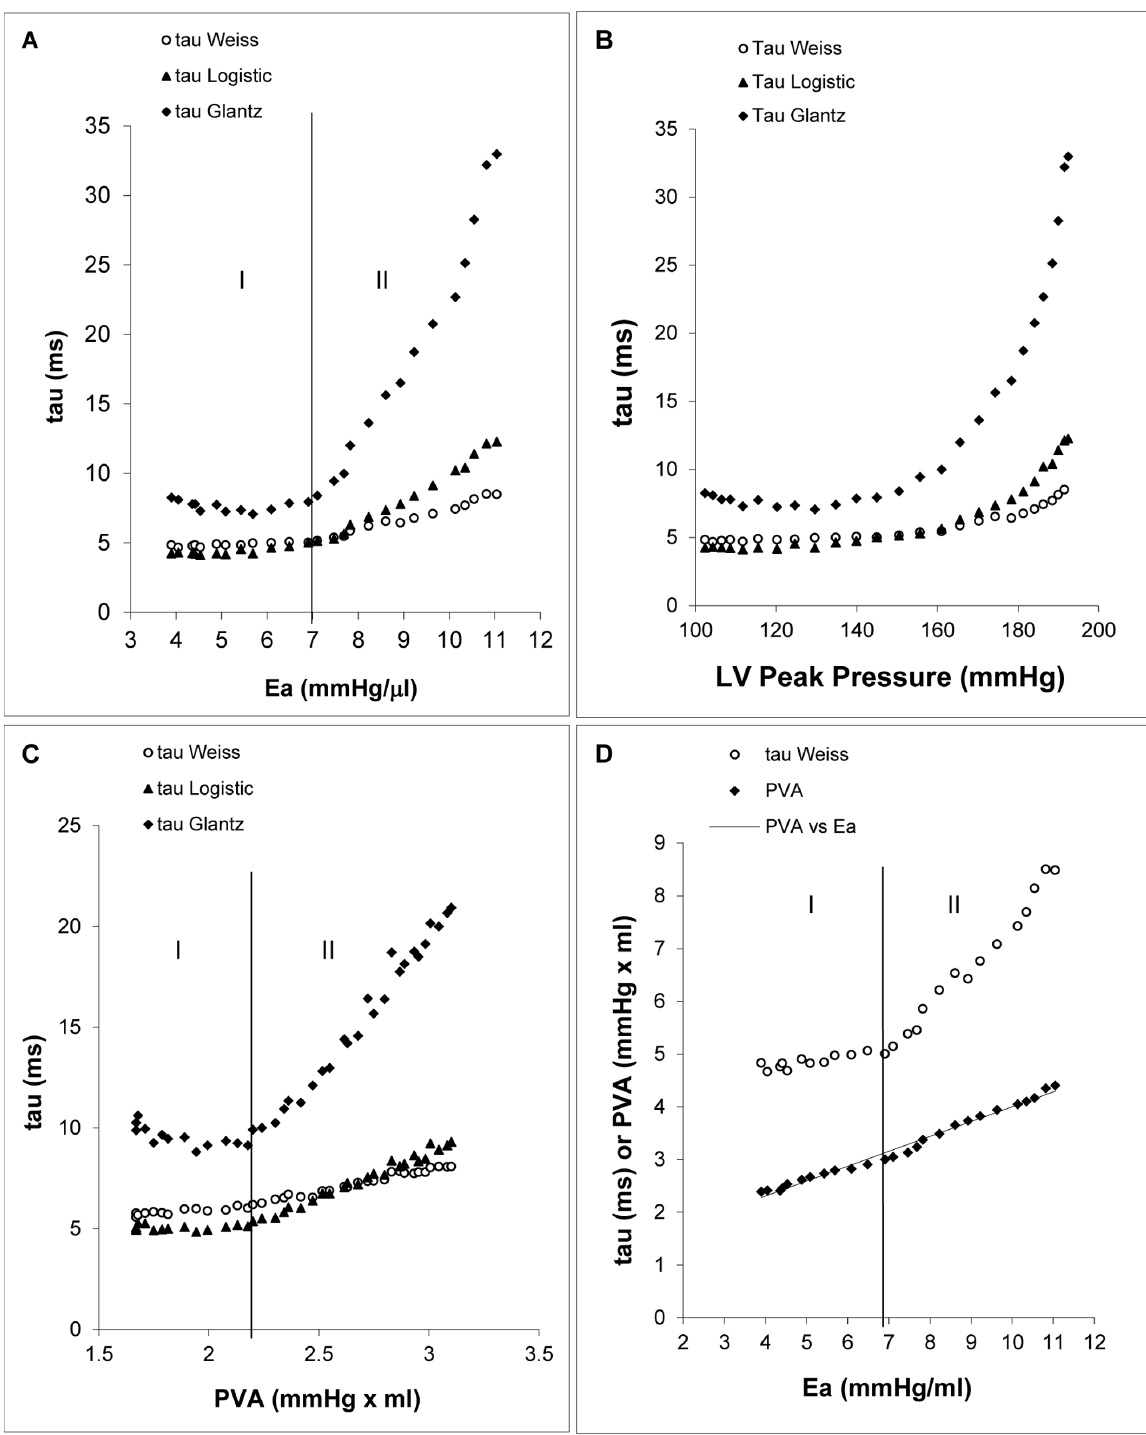
Figure 3. The relationship between t , Ea, LV peak systolic pressure, and pressure-volume area (PVA). Plots of the three t computations versus Ea (A), peak systolic pressure (B), and PVA (C) with phenylephrine injection. (D) Combined plots of t ( t Weiss ) and PVA versus Ea (PVA=282.63 6 Ea + 1178.5, R 2 =0.9858).